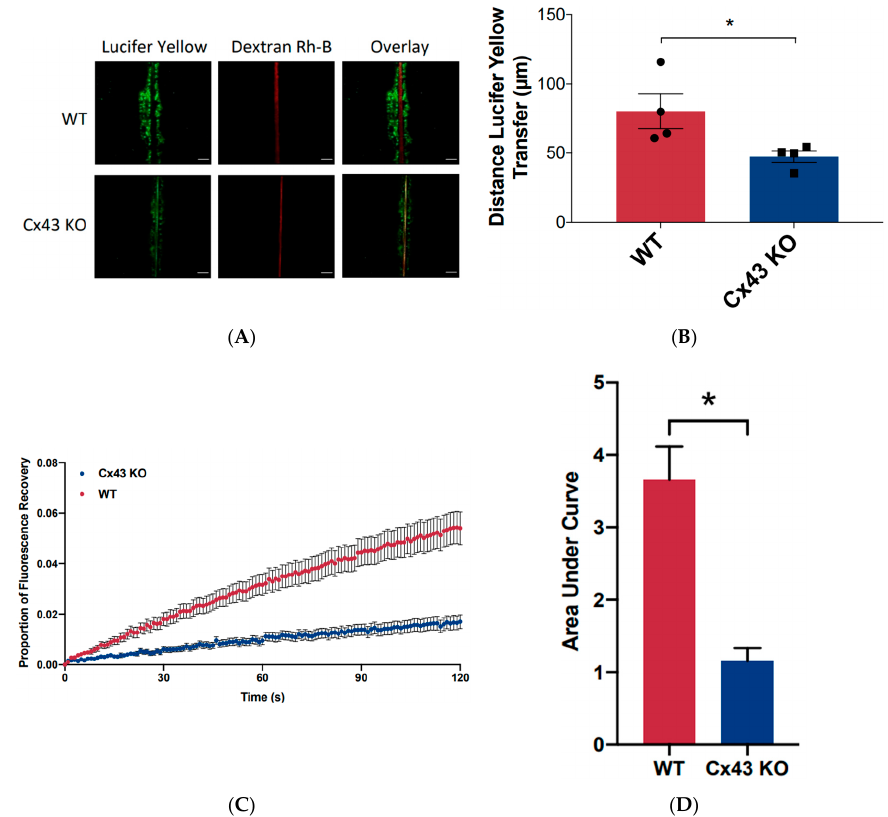
Figure 4. Cx43 ablation from REKs significantly reduced gap junctional intercellular communication. ( A ) Monolayers of wild-type (WT) REKs and REKs where Cx43 was knocked out (Cx43 KO) were scraped and loaded with Lucifer yellow and dextran-rhodamine B (Rh-B) to assess dye spread. Note that Lucifer yellow spread extensively from the wounded edge of WT cells but far less in Cx43 KO cells while dextran Rh-B was only found at the wound edge in both cases. ( B ) Quantification of dye transfer revealed that Cx43 KO cells were far less coupled by gap junctions compared to WT cells. Solid circles represent scattered WT points while solid squares represent scattered Cx43 KO points. ( C ) REKs and Cx43 KO REKs were loaded with calcein AM prior to one cell being laser photobleached. Fluorescence recovery mediated by dye transfer into the photobleached cell was tracked over 120 s. ( D ) Quantification of the area under the curve reflects that Cx43 KO exhibit less GJIC than WT REKs. * p < 0.05, data plotted as ± standard error of the mean (SEM), Bar = 10 µ